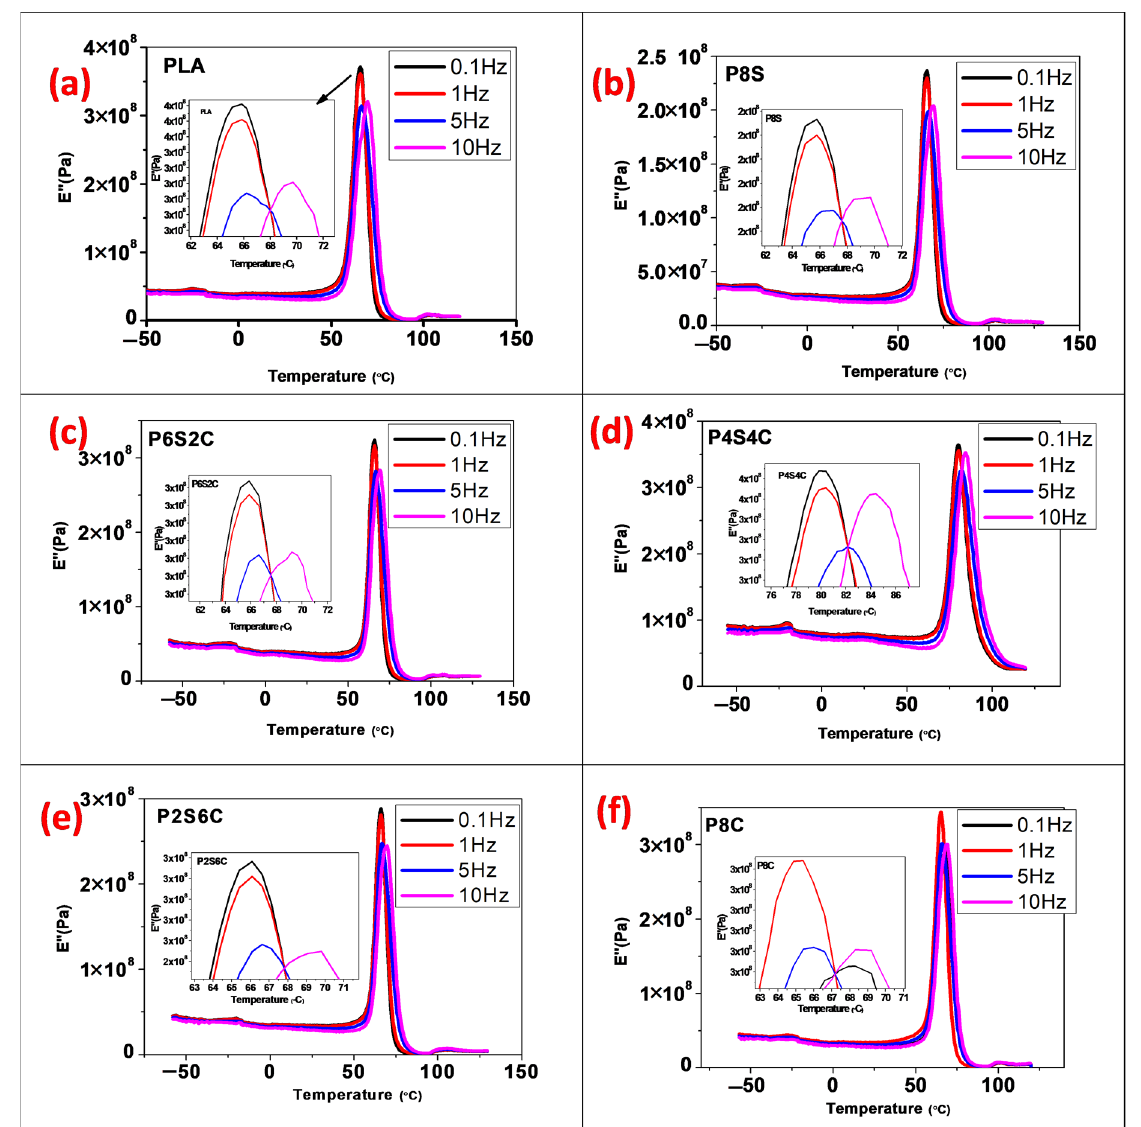
Figure 4. The effect of frequency on DMA loss modulus curves of the ( a ) PLA, ( b ) P8S, ( c ) P6S2C, ( d ) P4S4C, ( e ) P2S6C and ( f ) P8C